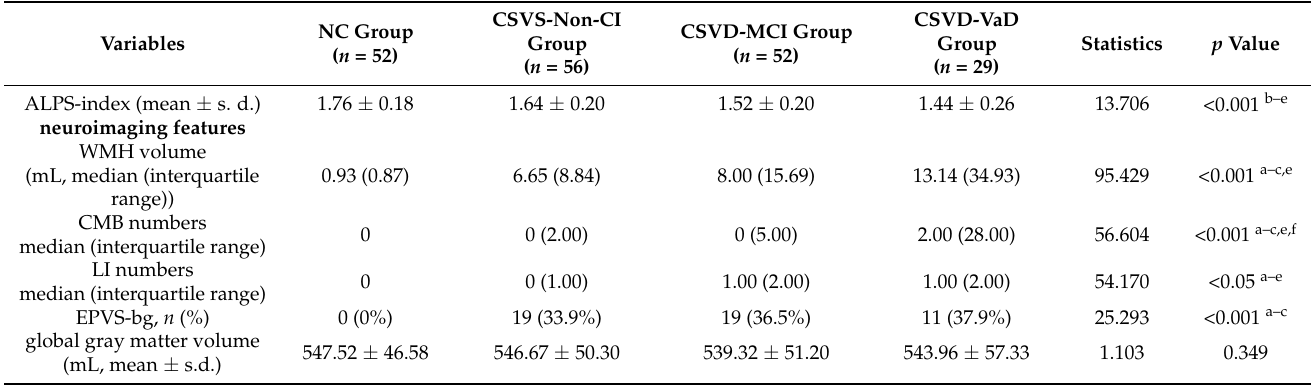
Table 3. ALPS-index and neuroimaging features in the NC, CSVD-non-CI, CSVD-MCI, and CSVD- VaD